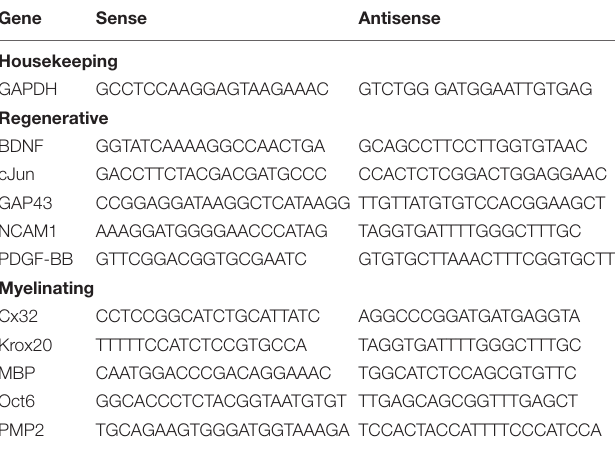
TABLE 4 | Primer set for assessment of Schwann cell gene